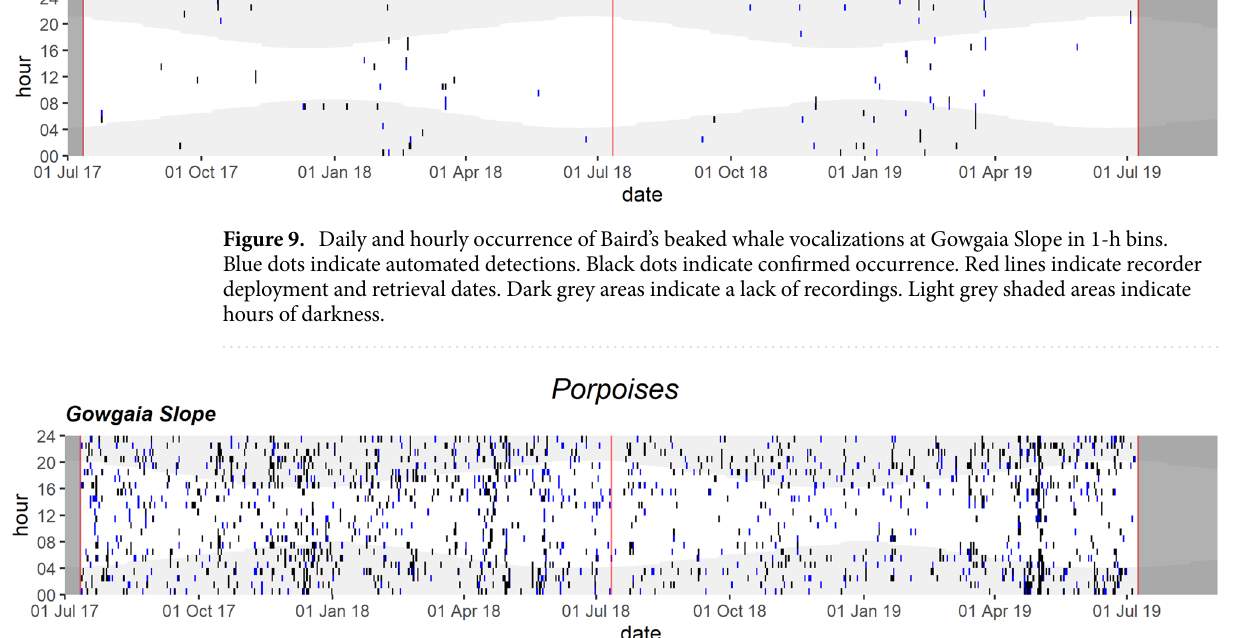
(Fig. 12). At RI, both delphinid whistles and clicks showed a diel trend, with higher acoustic presence at night than during the day (Figs. 11 and 12, S4). Contribution of cetacean calls to ambient noise levels.